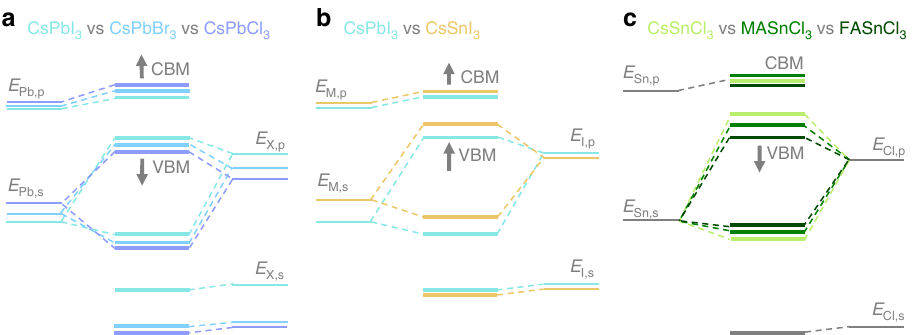
Fig. 4 Schematic energy levels in AMX 3 perovskites. a , b represent trends in changing the halide anions and the metal cations, respectively, as identi fi ed from the tight-binding analysis. c is an intuitive illustration of energy-level changes based on structural distortions in tin-based perovskites. Arrows indicate the shift in energy levels upon atom or small molecule